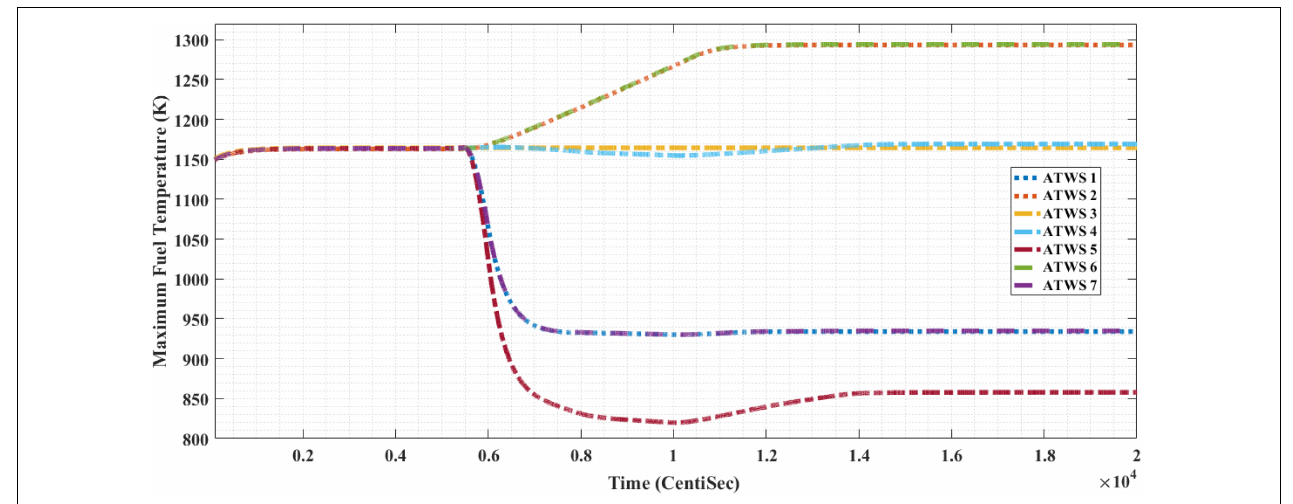
FIGURE 11 | Maximum fuel temperature during ATWS